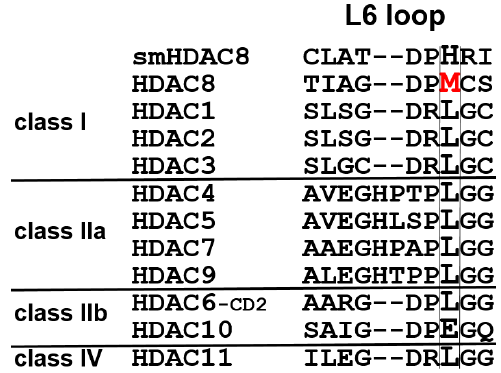
Figure 2. Multiple sequence alignment of the L6 loop across all human zinc-dependent HDAC isozymes and smHDAC8 from Schistosoma mansoni . M274 of human HDAC8 is highlighted in bold red.